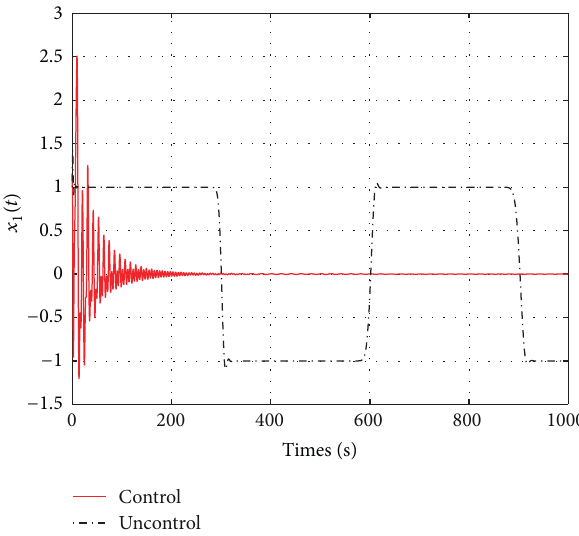
Figure 1: Oscillating spring-mass model.